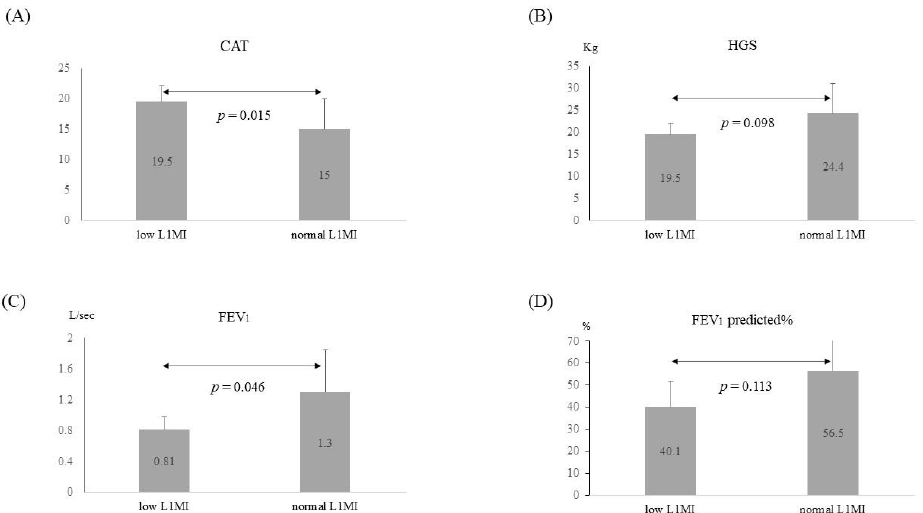
Figure 3. Comparison of CAT, HGS, FEV 1, and FEV 1 predicted% between COPD subjects with low L1MI and normal L1MI. Comparing to COPD subjects with normal L1MI, those with low L1MI had ( A ) higher CAT scores (19.5 ± 2.6 vs. 15.0 ± 4.9), ( B ) marginally lower HGS (19.5 ± 2.6 vs. 24.4 ± 6.7 kg), ( C ) lower FEV 1 (0.81 ± 0.17 vs. 1.30 ± 0.55 L/s), and ( D ) tended to have lower FEV 1 % of the predicted value (40.1 ± 11.8% vs. 56.5 ± 20.1%). Abbreviation: CAT: COPD assessment test; HGS: handgrip strength; FEV 1 : force expiratory volume in one second; FEV 1 predicted%: the percentage of predicted FEV 1 ; L1MI: the ratio of muscle surface (cm 2 ) at L1 to height squared (m 2 ); COPD: chronic obstructive pulmonary disease. The numbers in the boxes are mean values. Vertical lines represent standard deviations.